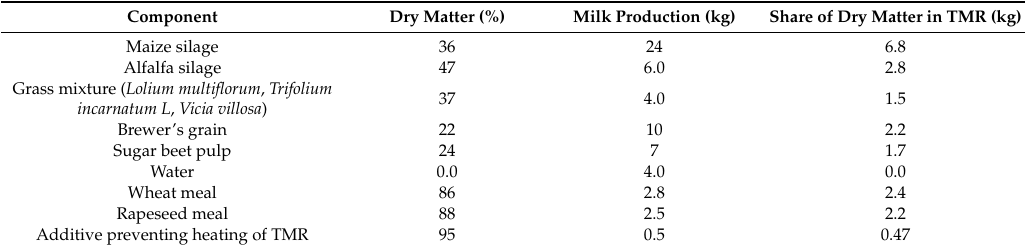
Table 1. Total mixed ration